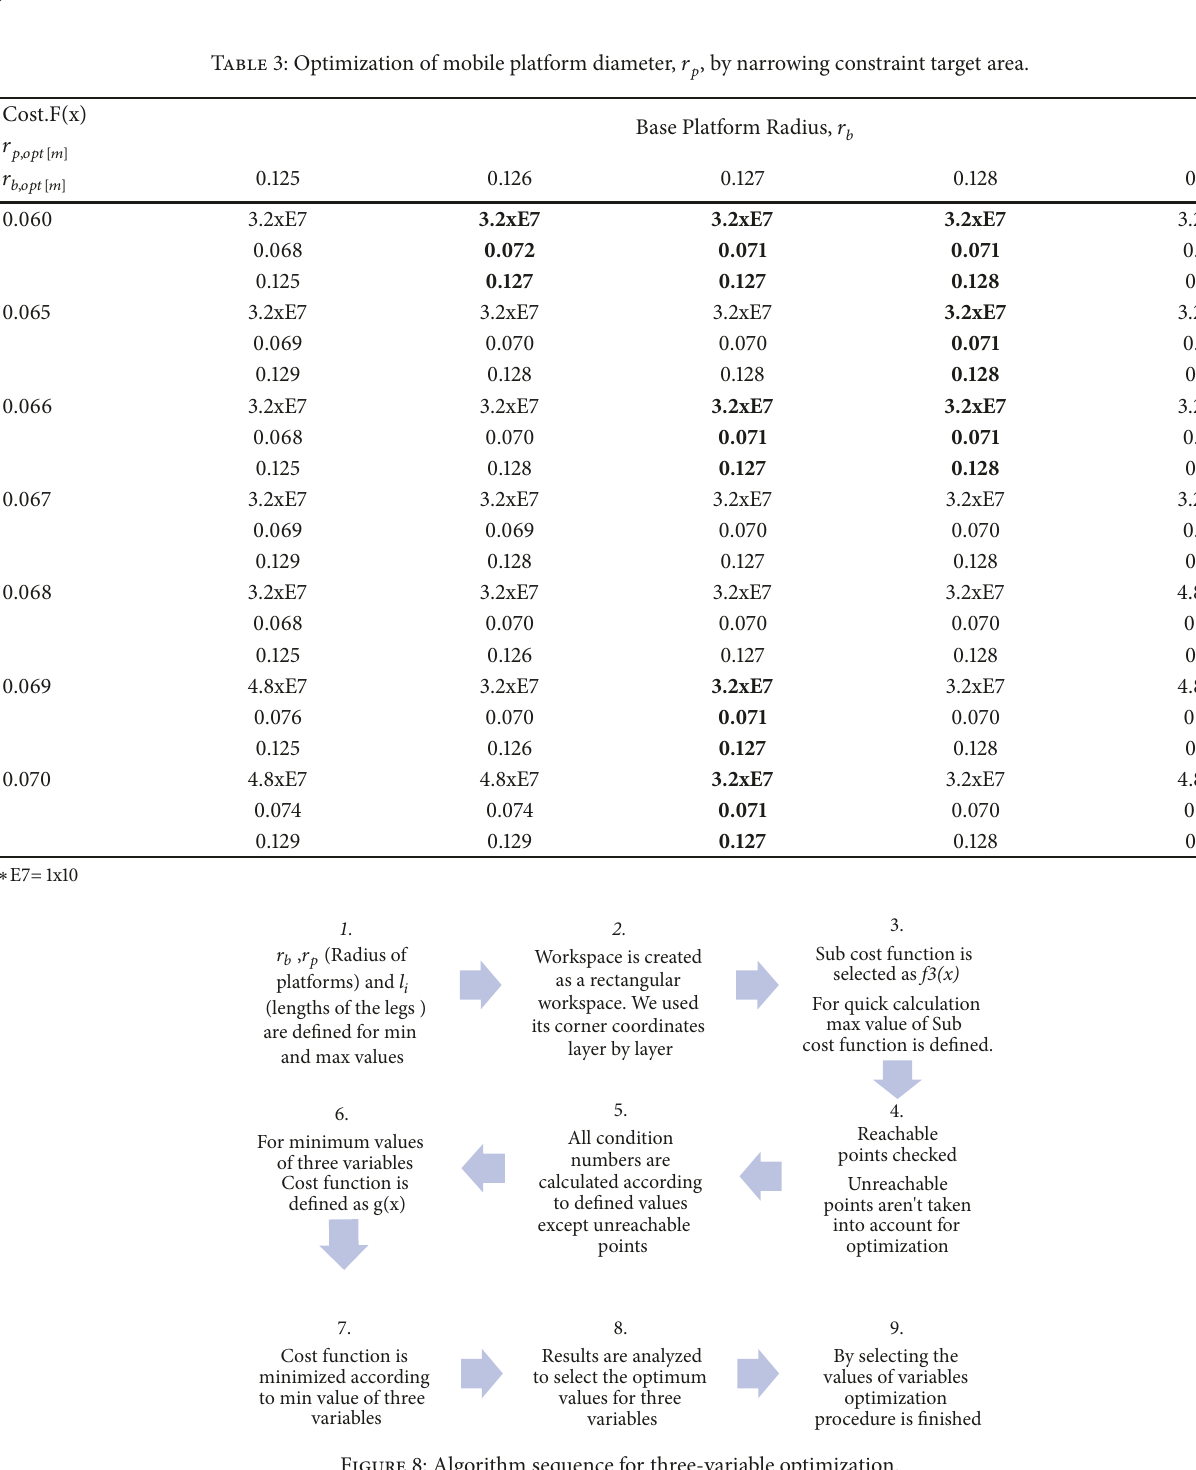
Figure 8: Algorithm sequence for three-variable